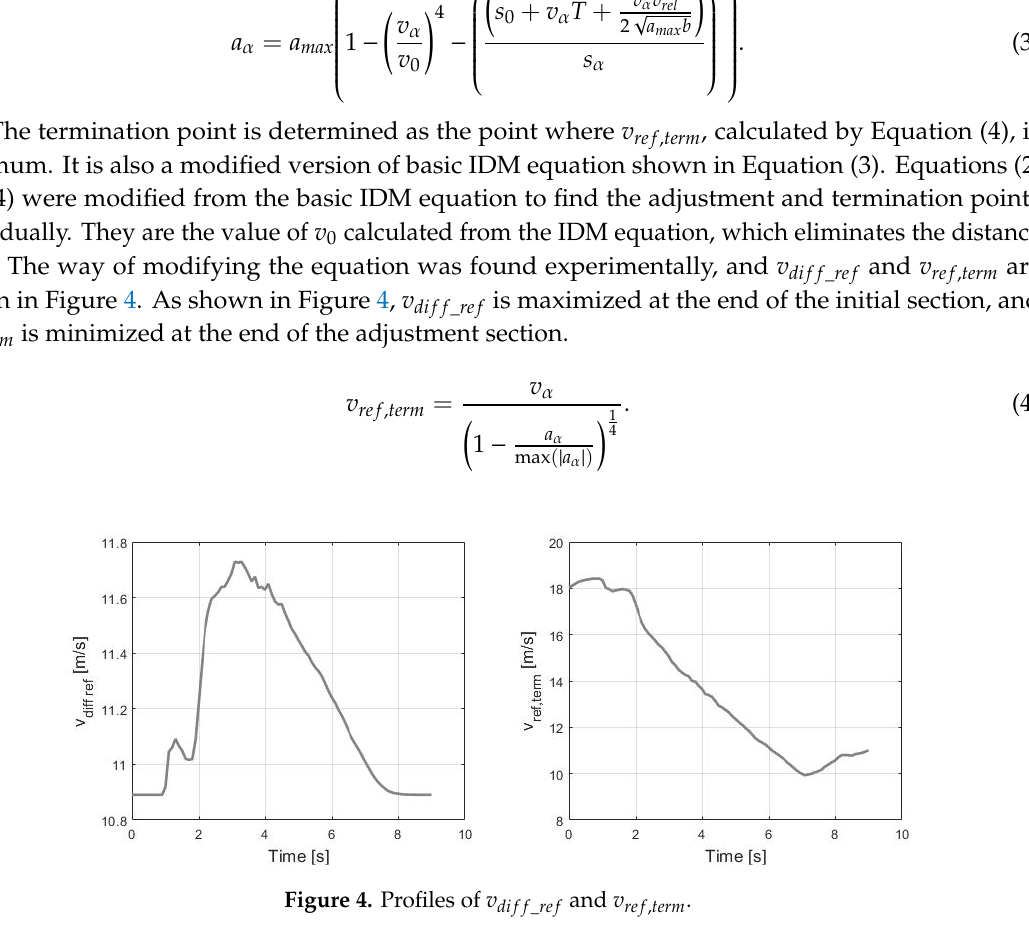
Figure 4. Profiles of 𝑣 (cid:3031)(cid:3036)(cid:3033)(cid:3033)_(cid:3045)(cid:3032)(cid:3033) and 𝑣 (cid:3045)(cid:3032)(cid:3033),(cid:3047)(cid:3032)(cid:3045)(cid:3040) . Figure 4. Profiles of v dif f _ ref and v ref , term .